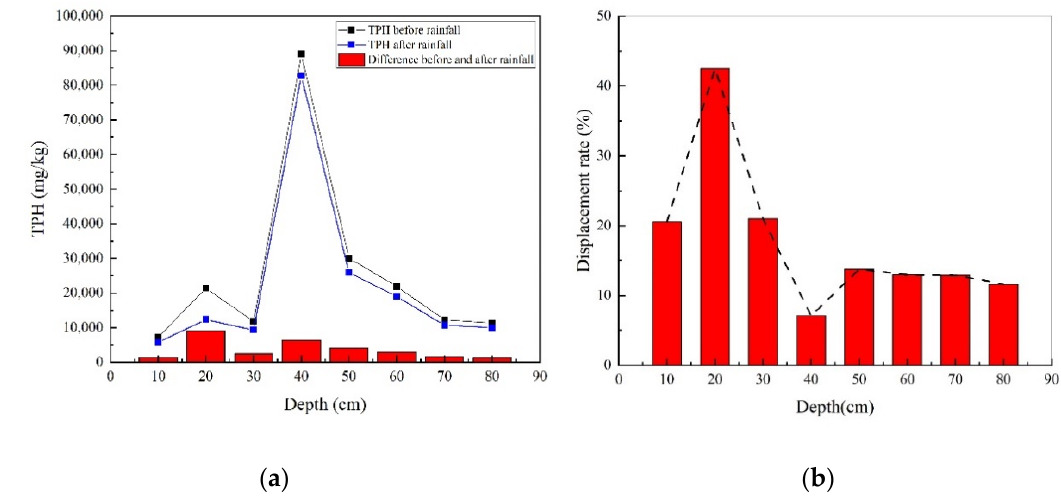
Figure 8. ( a ) TPH concentration before and after rainfall and ( b ) diesel displacement rates at different depths in the M-F-C tank.